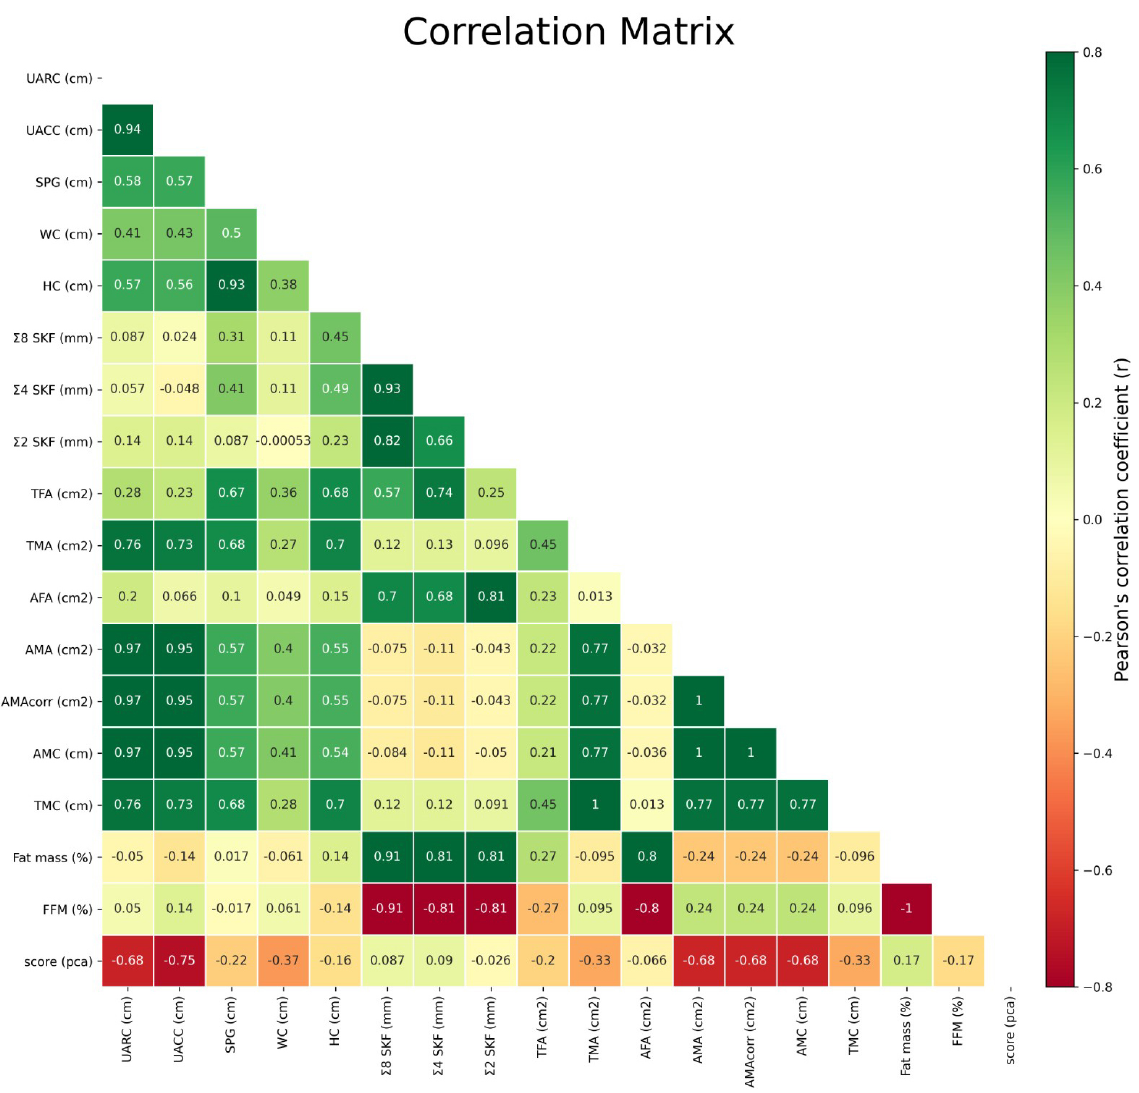
Fig. 1. Correlation matrix on a heat map. Note: UARC, upper arm relaxed circumference; UACC, upper arm contracted circum- ference; SPG, suprapatellar girth; WC, waist circumference; HC, hip circumference; Ʃ8 SKF, sum of 8 skinfolds; Ʃ4 SKF, sum of 4 skinfolds; Ʃ2 SKF, sum of 2 skinfolds; TFA, thigh fat area; TMA, thigh muscle area; AFA, arm fat area; AMA, arm muscle area; AMAcorr, corrected arm muscle area; AMC, arm muscle circumference; TMC, thigh, muscle circumference; FFM, fat-free